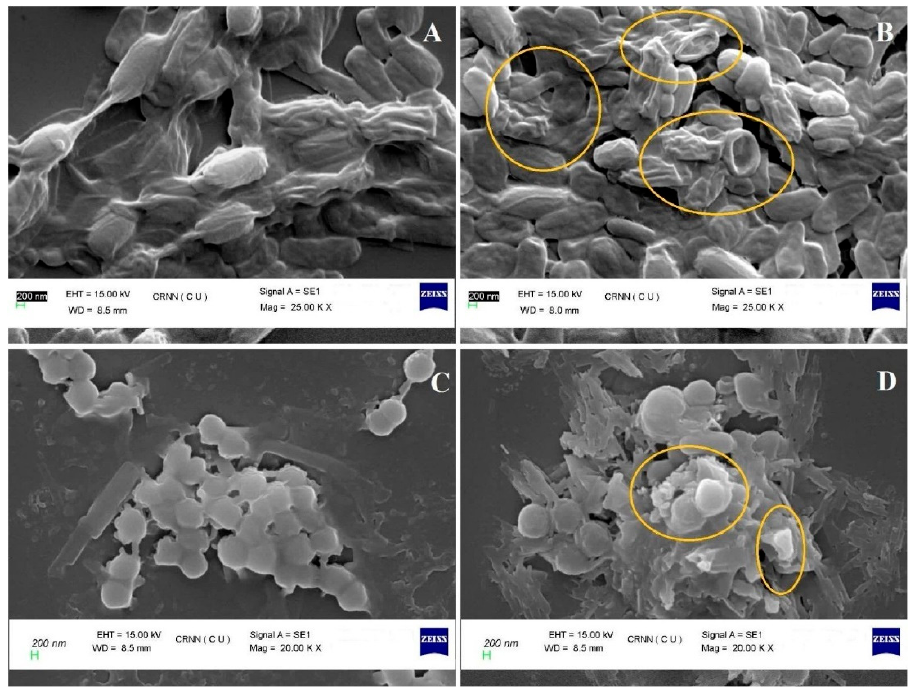
Figure 5. Scanning electron microscopy (SEM) images of ( A ) dead and shriveled Escherichia coli treated with ciprofloxacin alone; ( B ) more affected cells (marked) by ciprofloxacin with surfactant EPS; ( C ) dead Staphylococcus aureus with disruption of coccoid morphology by ciprofloxacin alone; ( D ) more affected cells (marked) by ciprofloxacin with surfactant EPS. Reprinted from Sengupta et al. [14]. Copyright (2020), with permission from Elsevier.